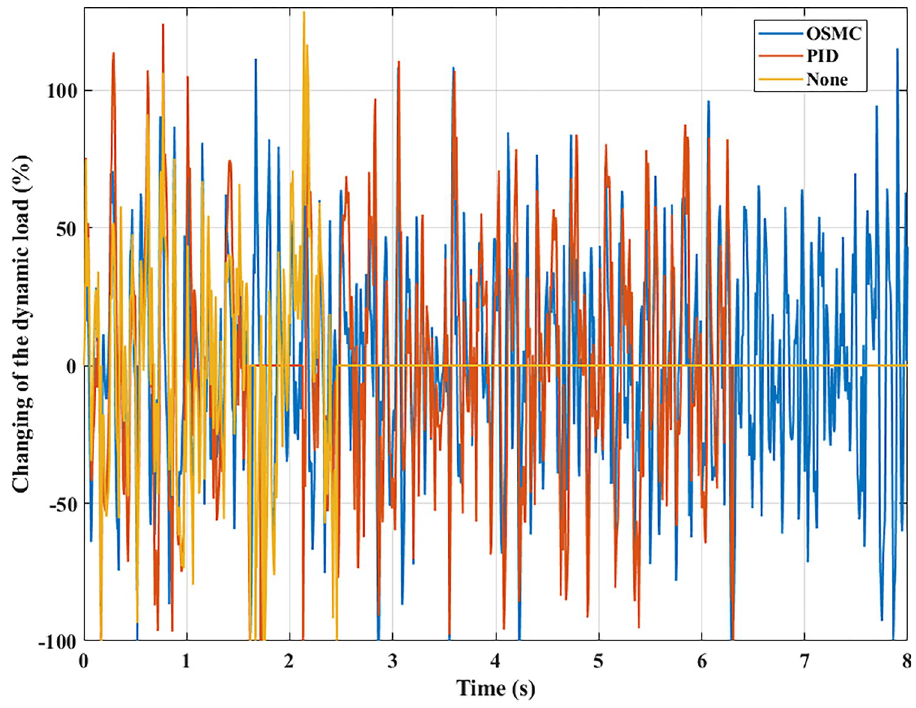
Fig 20. Changing the dynamic load (case 4).